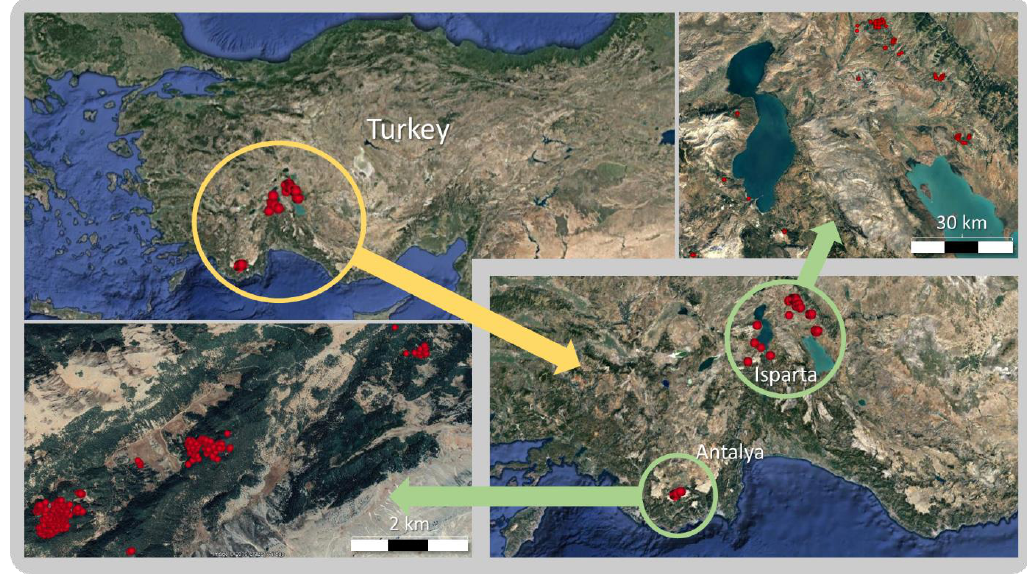
Figure 1. Study sites in Antalya and Isparta, Turkey.